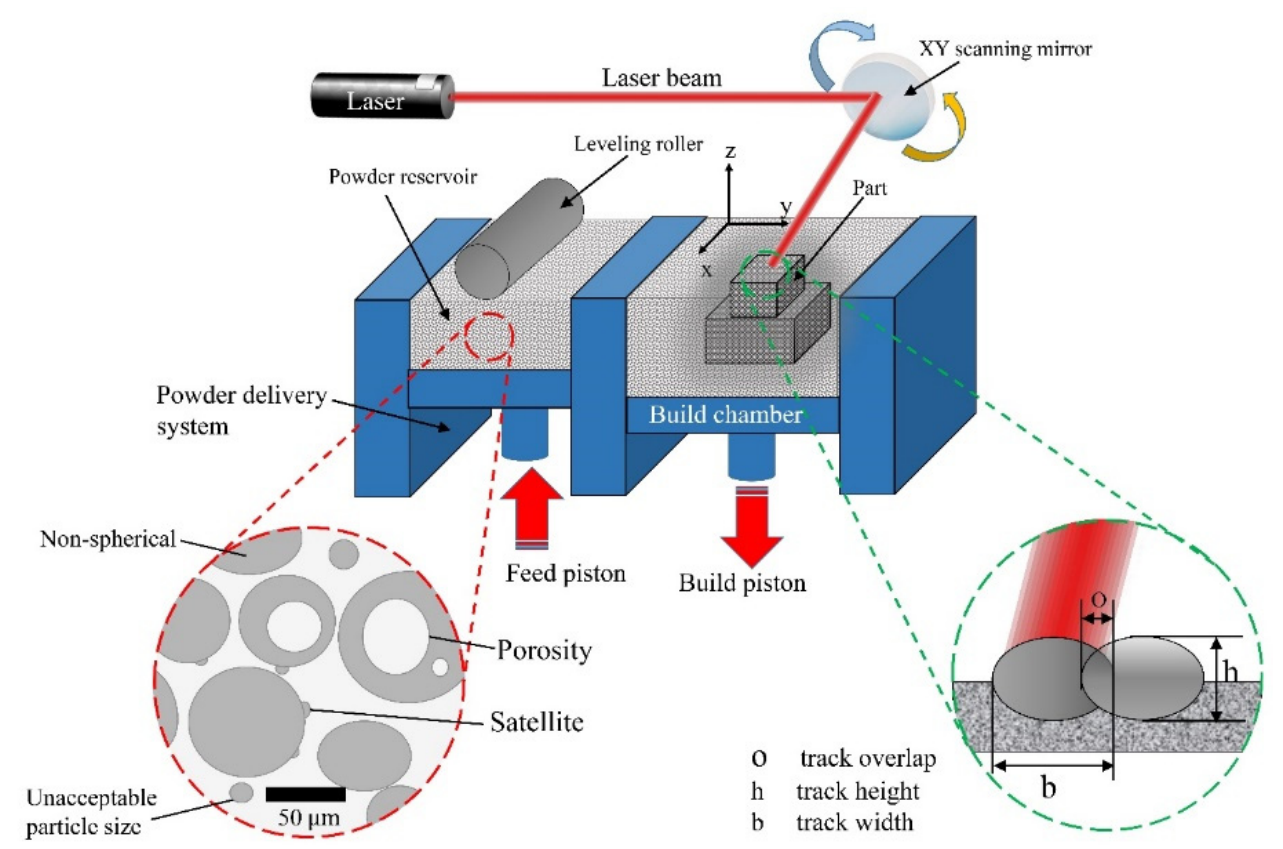
Figure 1. Schematic of selective laser sintering (SLS) [30].